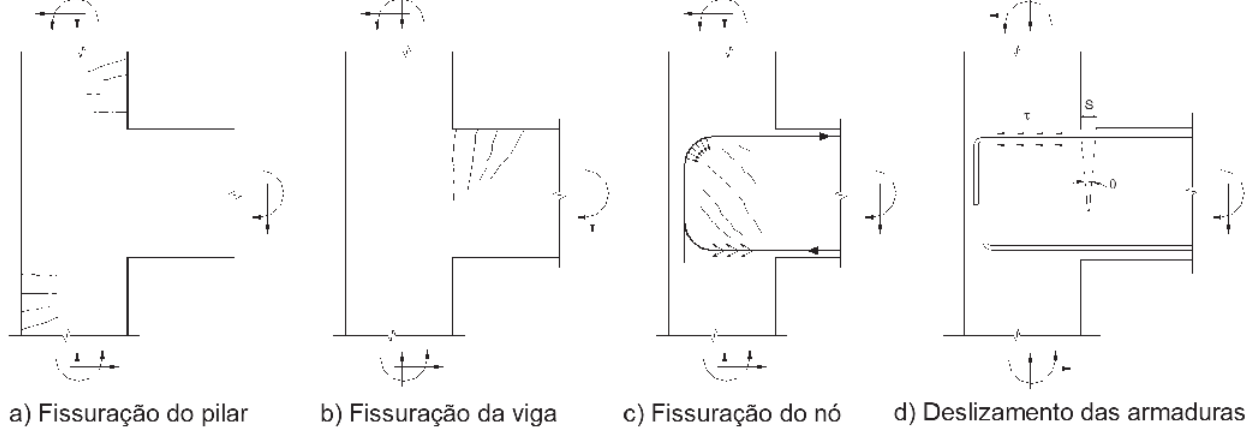
Fissuração e deslizamento das armaduras existente em nós de pórtico